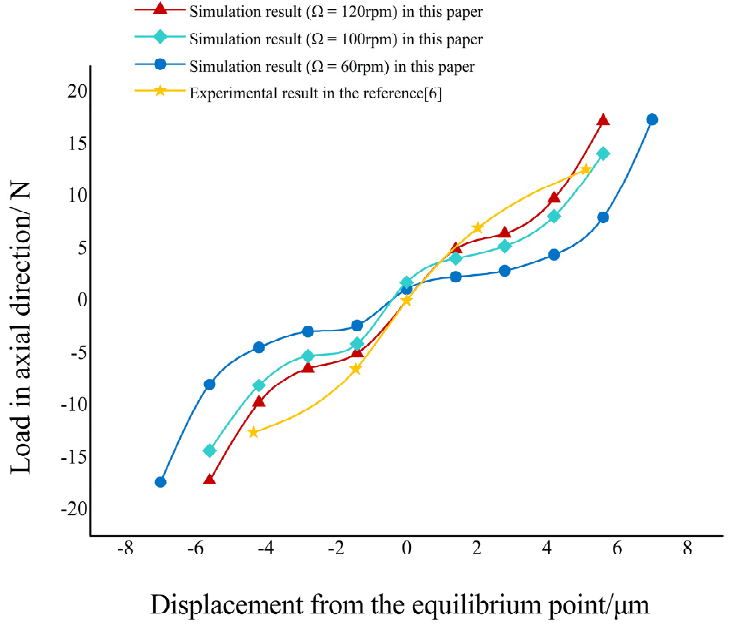
Figure 6. Comparisons between the simulation results and experimental data.